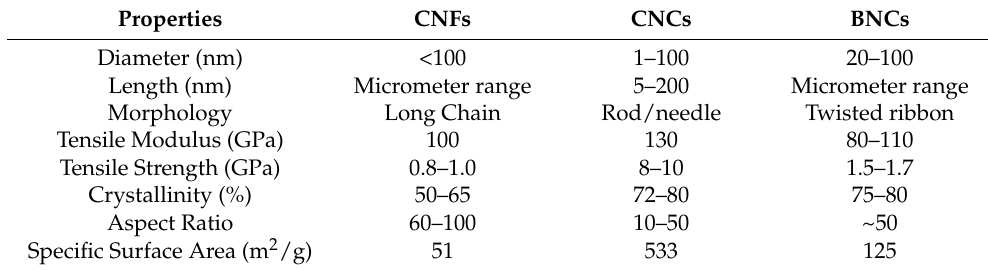
Table 1. Nanocellulose characteristics data from